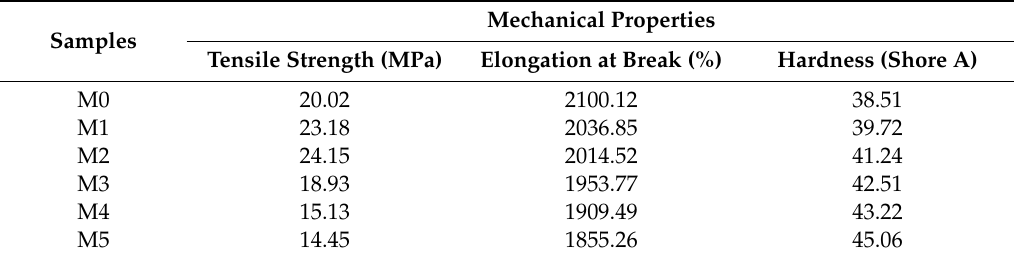
Table 3. Mechanical properties of cured NR / silica compounds.